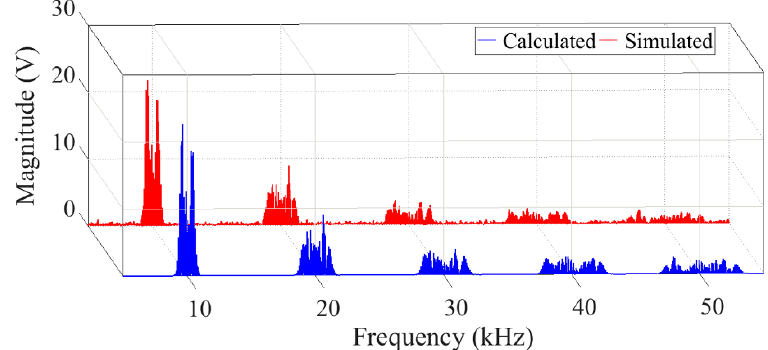
Figure 6. Comparison between the calculated spectrum and the simulated spectrum of the v DMS for the sinusoid PCFM APF with f c = 500 Hz.